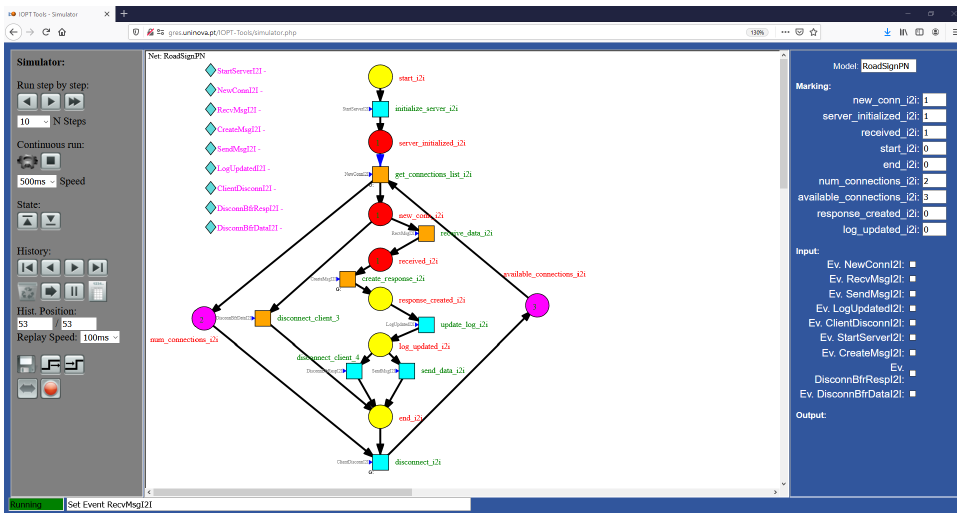
Figure 6. The IOPT simulation tool with the model of the controller of the NOVA-WiFi-Beacon Provider (NWBP)